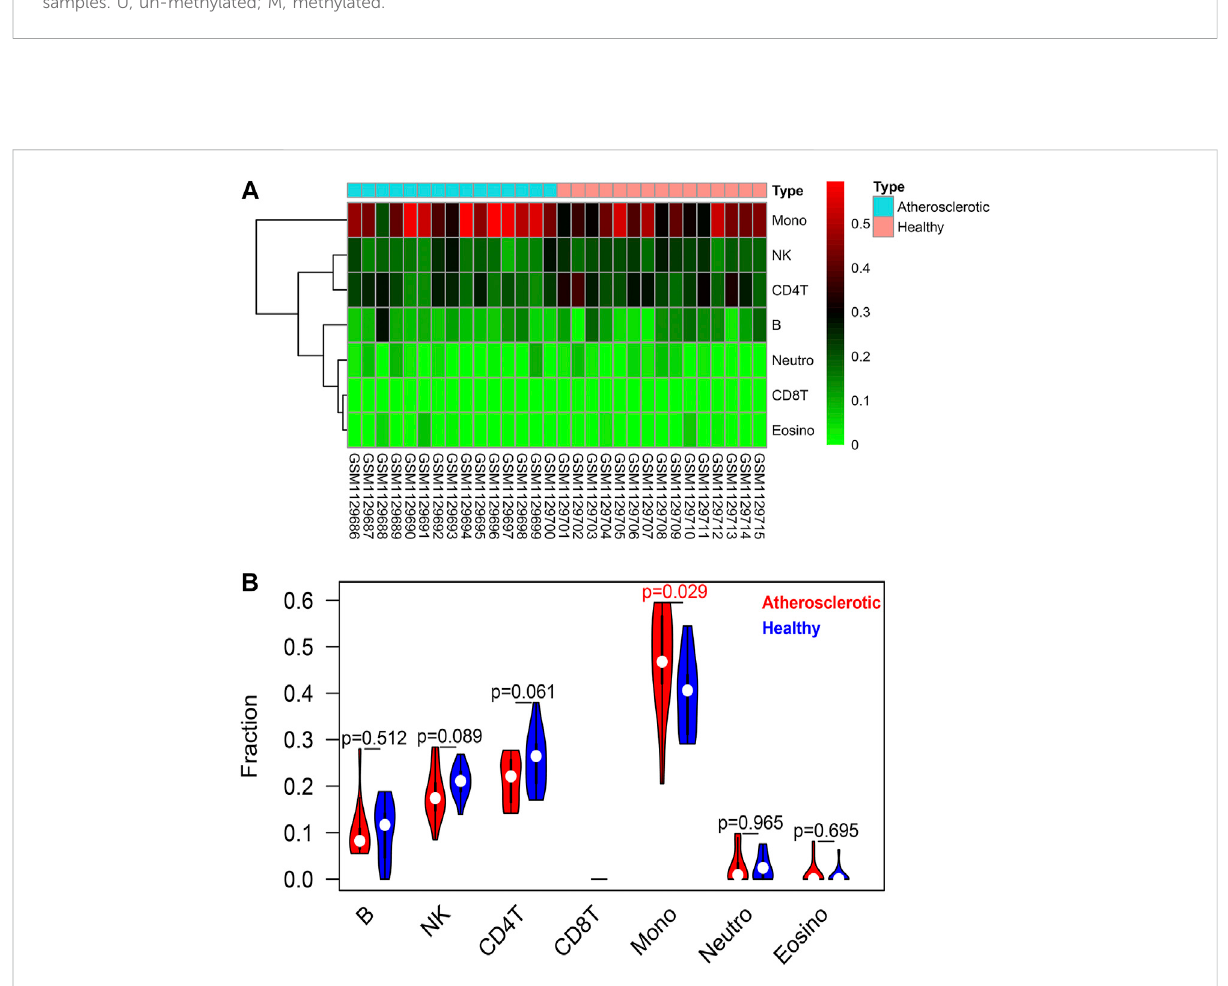
FIGURE 6 Immune-cell in fi ltration analysis based on the EpiDISH algorithm. (A) Heat map of the in fi ltration levels of seven types of immune cells (B cells, NKcells, CD4 + Tcells,CD8 + Tcells,monocytes,neutrophils,andeosinophils). (B) Violinplotanddifferenceanalysis betweentheatheroscleroticand healthy